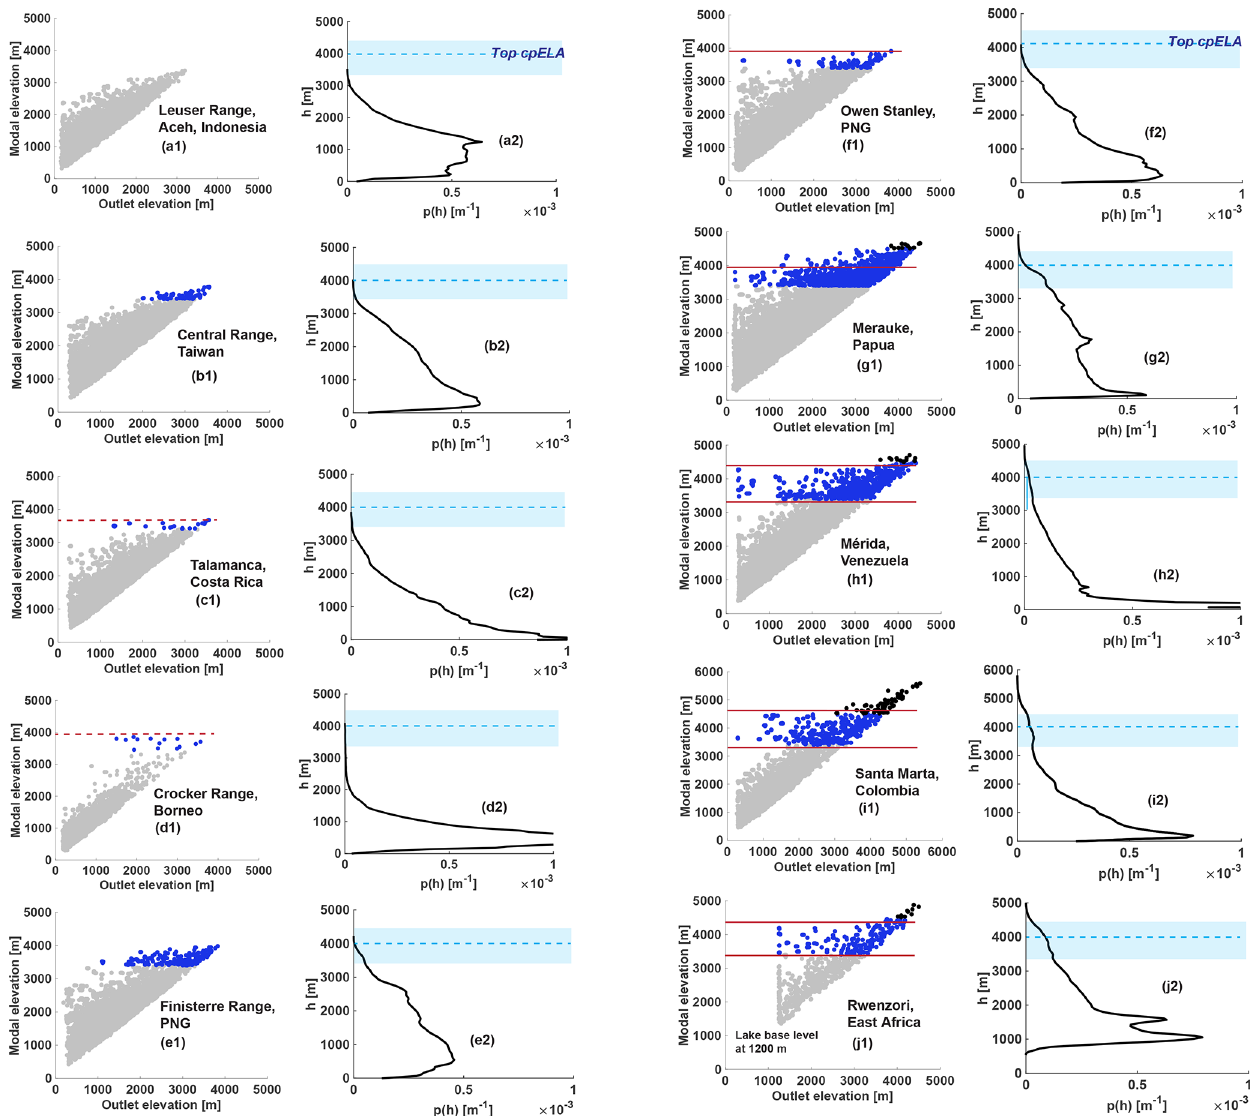
Figure 8. Progressive hypsometry and mountain range hypsometry for selected mountain ranges (Fig. 3). (a1–j1) Progressive hypsometry (see Figs. 4–5) for each mountain range. Each gray point is a catchment with associated modal elevation ( y axis) and outlet ( x axis). Blue points are those catchments with a modal elevation within the range of the tropical ELA (cpELA: 3400–4000m; wpELA 4500m). Black points are above wpELA (4500m). Red lines indicate left spread of modal elevation. These catchments are characterized by a strong, high modal elevation. (a2–j2) Mountain range hypsometry. Light blue box is range of ELA (cpELA through wpELA). Dashed blue line is the top of the tropical cpELA